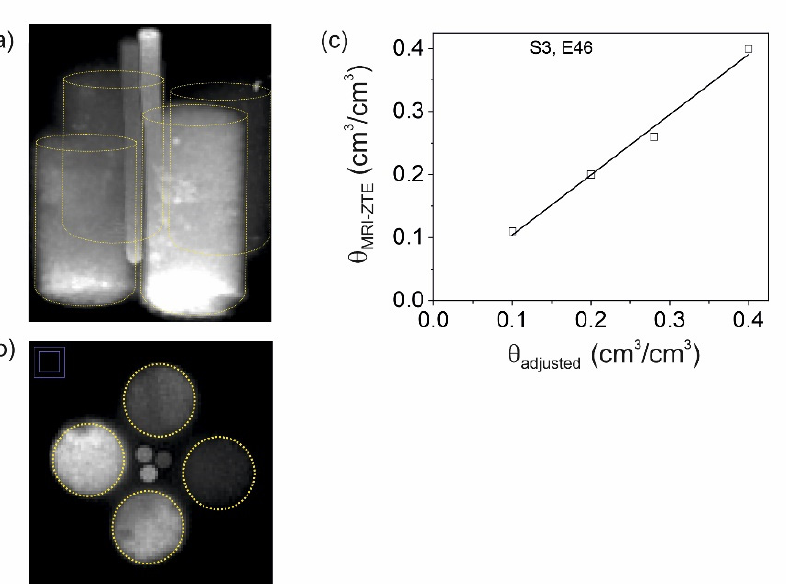
Figure 5. Quantification of water content in sandy loam by means of MRI-ZTE, sample S3. ( a ) The maximum intensity projection shows the four cuvettes with volumetric water contents of 0.10, 0.19, 0.28, and 0.40 cm 3 /cm 3 . The raw images were normalized firstly on the homogeneity phantom R1 to compensate for radial signal-intensity inhomogeneities and secondly on the signal intensity from the reference cuvettes visible in the center with known volumetric water contents. The yellow wireframes indicate the positions of the cuvettes. ( b ) Axial cross section through the ZTE image. ( c ) Water content obtained from MRI-ZTE versus volumetric water content from sample weights.